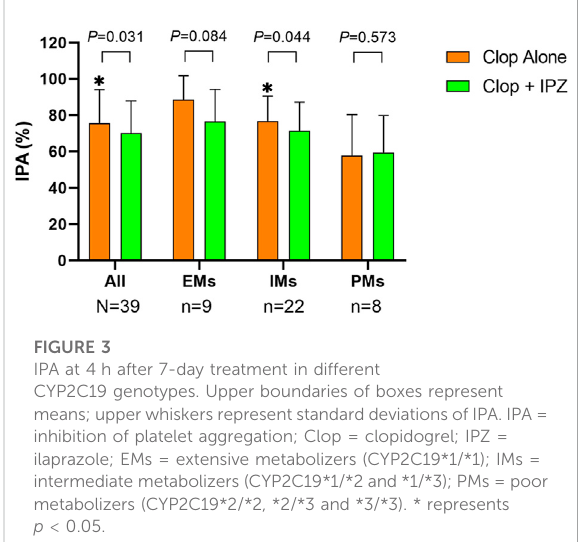
FIGURE 3 IPA at 4 h after 7-day treatment in different CYP2C19 genotypes. Upper boundaries of boxes represent means; upper whiskers represent standard deviations of IPA. IPA = inhibition of platelet aggregation; Clop = clopidogrel; IPZ = ilaprazole; EMs = extensive metabolizers (CYP2C19*1/*1); IMs = intermediate metabolizers (CYP2C19*1/*2 and *1/*3); PMs = poor metabolizers (CYP2C19*2/*2, *2/*3 and *3/*3). * represents p <